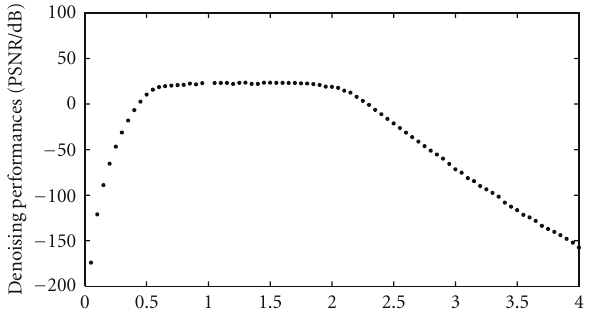
Figure 9: Data fitting result about optimal samples.